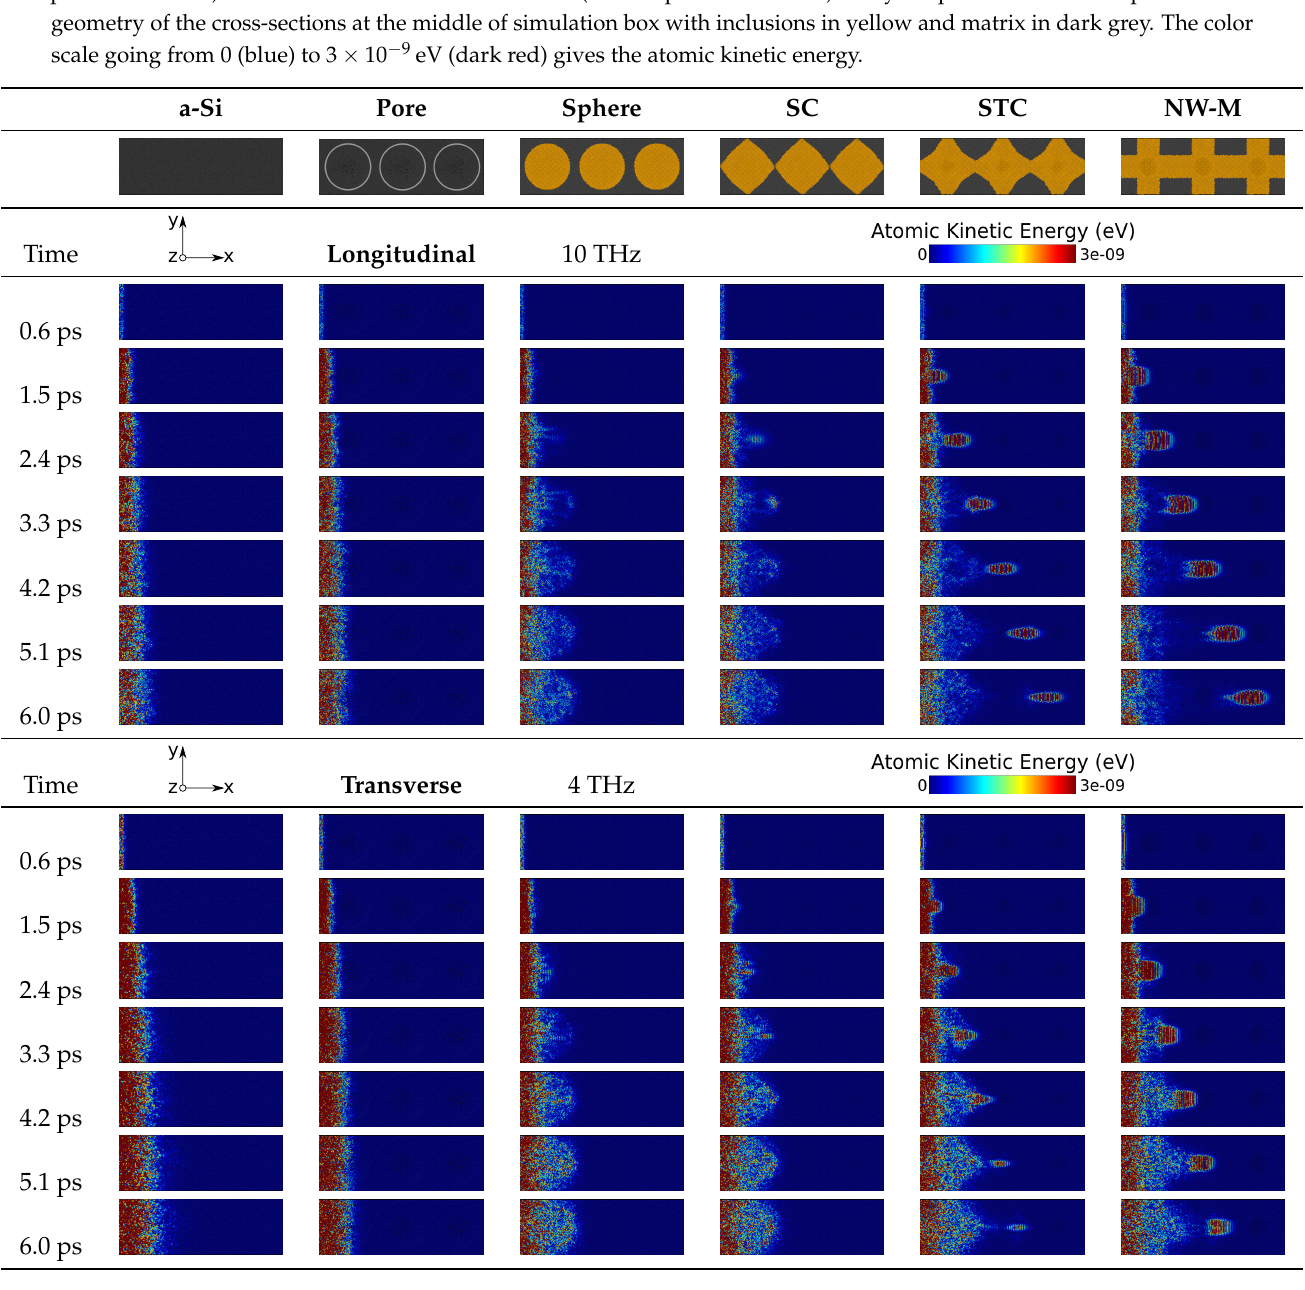
Table 3. Cross-sectional view of a WP going through the different systems after a longitudinal excitation at 10 THz (first part of the table) or a transverse excitation at 4 THz (second part of the table) every 0.9 ps. The first line represents the geometry of the cross-sections at the middle of simulation box with inclusions in yellow and matrix in dark grey. The